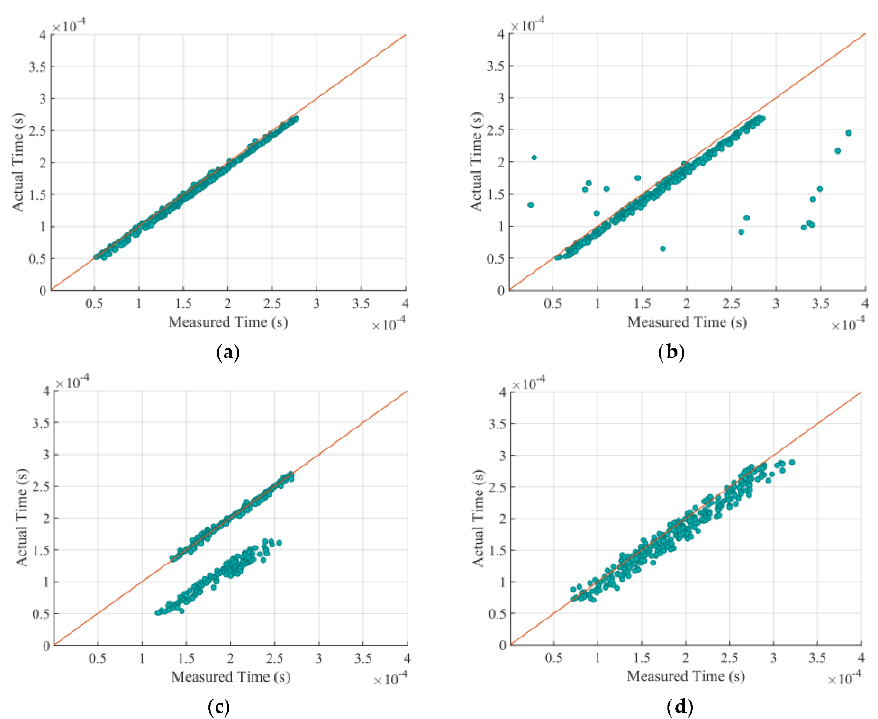
Figure 7. Distribution of measured values and the corresponding actual values on 10dB: ( a ) proposed; ( b ) STA/LTA; ( c ) AIC; ( d ) TKEO.